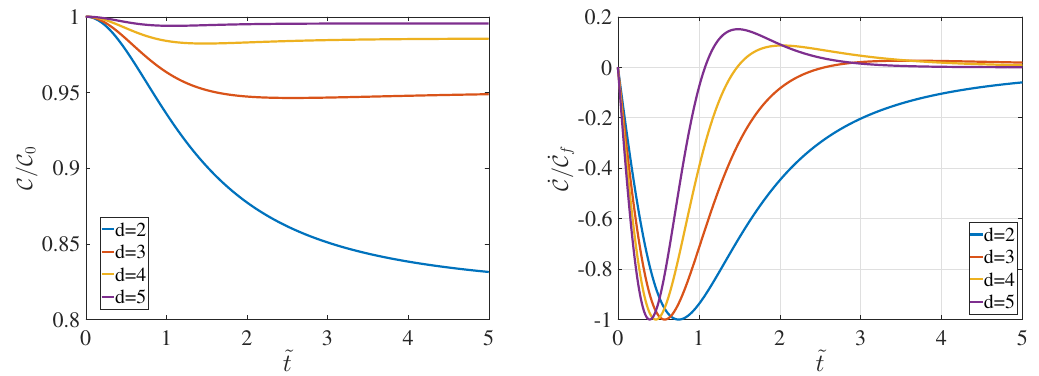
Figure 7 . The numerical values of C and _ C at d = 2 ; 3 ; 4 ; 5. Here C 0 is the complexity when ~ t = 0 and _ C f = (cid:0) _ C min . They show that _ C will (cid:12)rst decease linearly with respective to time ~ t and then increase later. Finally, the _ C goes to